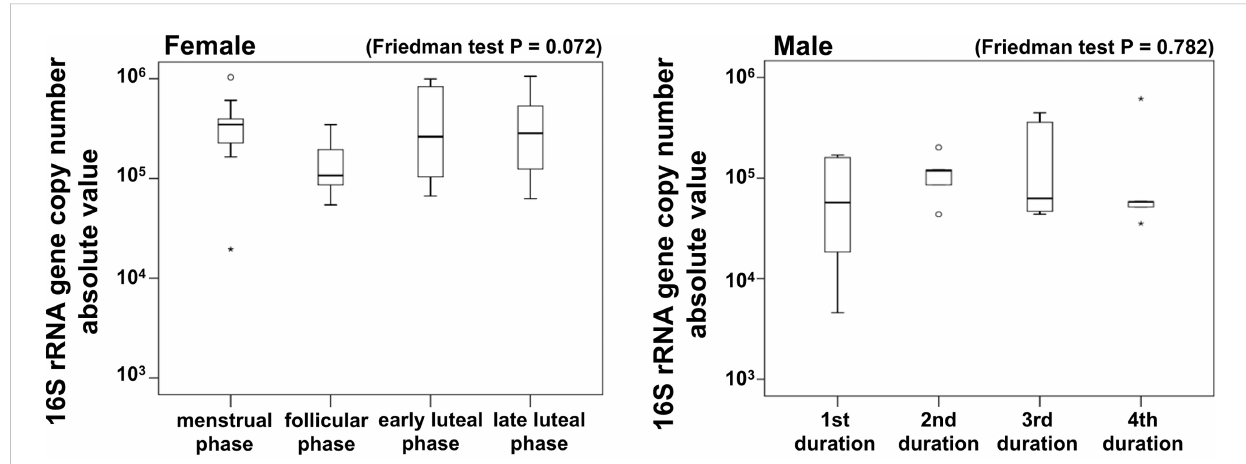
FIGURE 4 Copy numbers of the 16S rRNA gene collected by saliva samples. Data is shown in box plots. Friedman test and Bonferroni test. Females, N = 9; Males, N = 5. The vertical axis was a base-10 log scale. rRNA, ribosomal